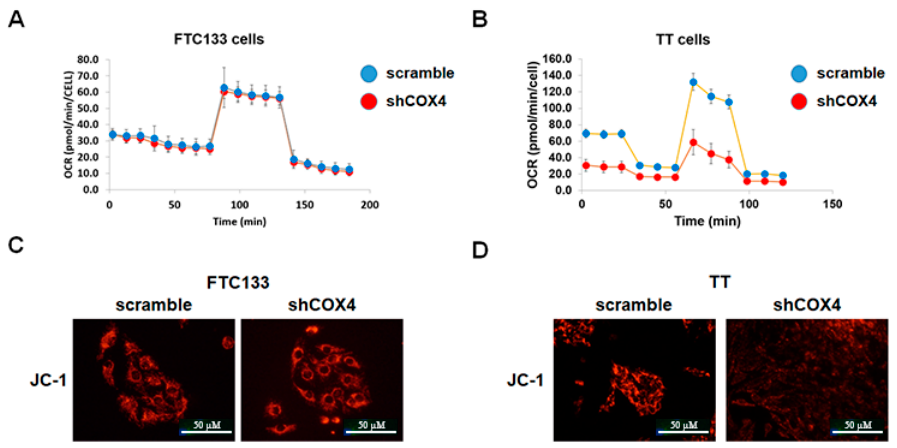
Figure 4. Assessment of mitochondrial function in COX4-expressing and COX4-deficient thyroid cancer cells. ( A ) Minimal effects of COX4 knockdown on mitochondrial respiration, ATP production,